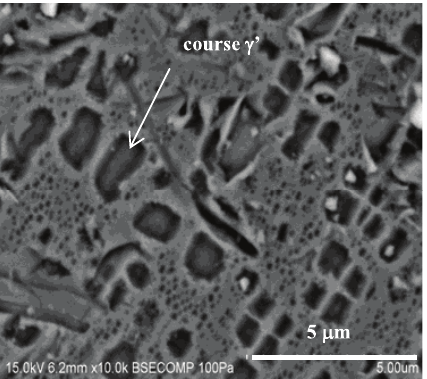
Figure 13. As-received microstructure after long-term ser- vice showing the coalescence of (cid:2) 0